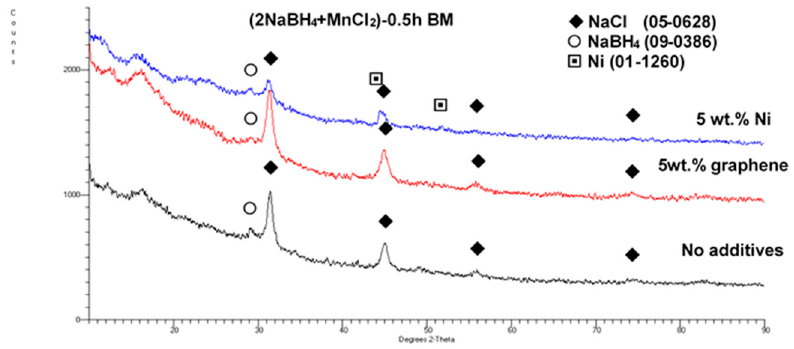
Figure 2. X-ray diffraction (XRD) patterns for the (2NaBH 4 + MnCl 2 ) sample additive-free, and with 5 wt. % additives of filamentary Ni and graphene, ball milled (BM) for 0.5 h.